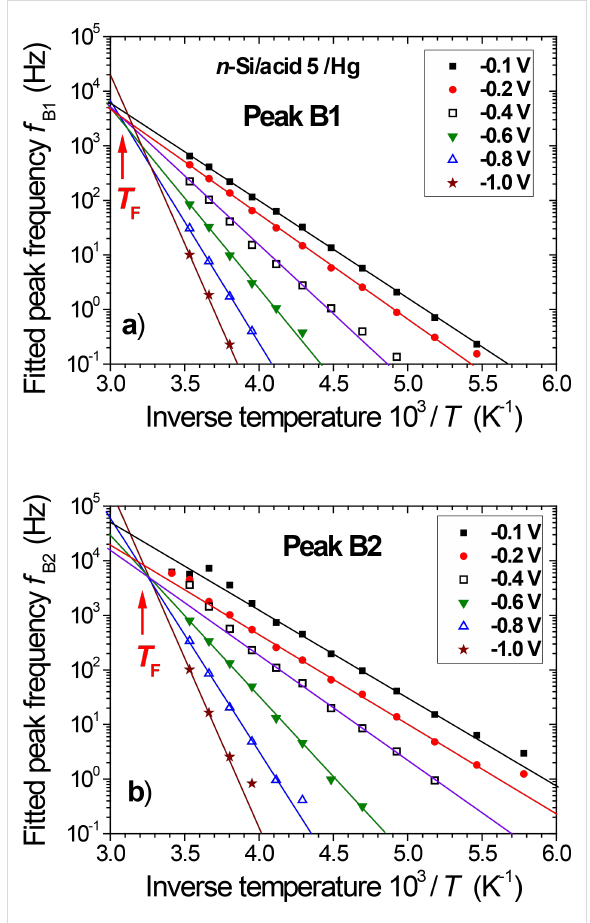
Figure 4: Temperature dependence of the dipolar relaxation frequen- cies f B1 (a) and f B2 (b) obtained for the Hg/acid 5 / n-type Si junction at different reverse bias values ( V DC range from − 0.1 V to − 1.0 V). The lines are Arrhenius fits to the data, showing the existence of a "focal point" near T F ≈ 320 K.